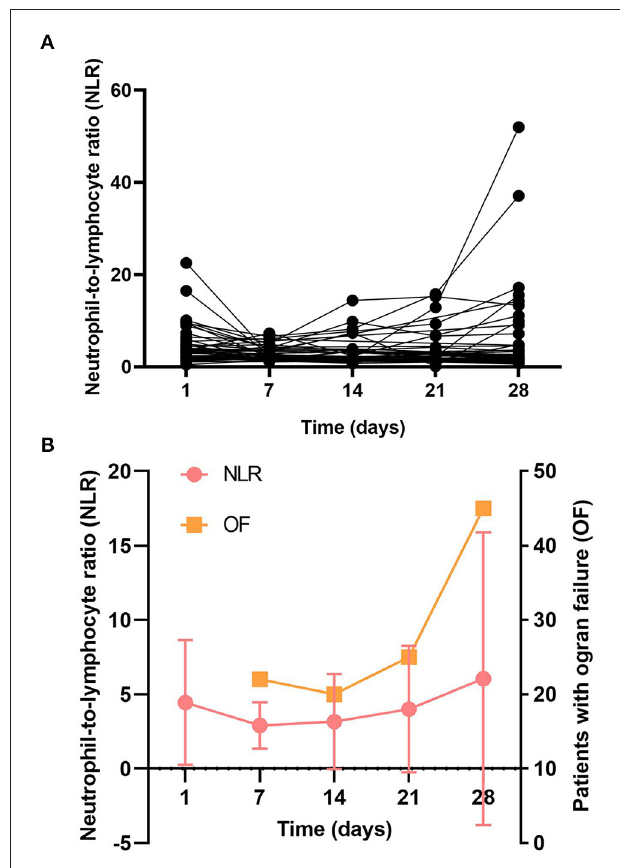
FIGURE 5 | The longitudinal association of NLR and organ dysfunction. Patients were dichotomized into those who did not have organ failure at baseline and subsequently developed organ failure. (A) The longitudinal curves of NLR over time; (B) Kinetic analysis of the number of organ failure and